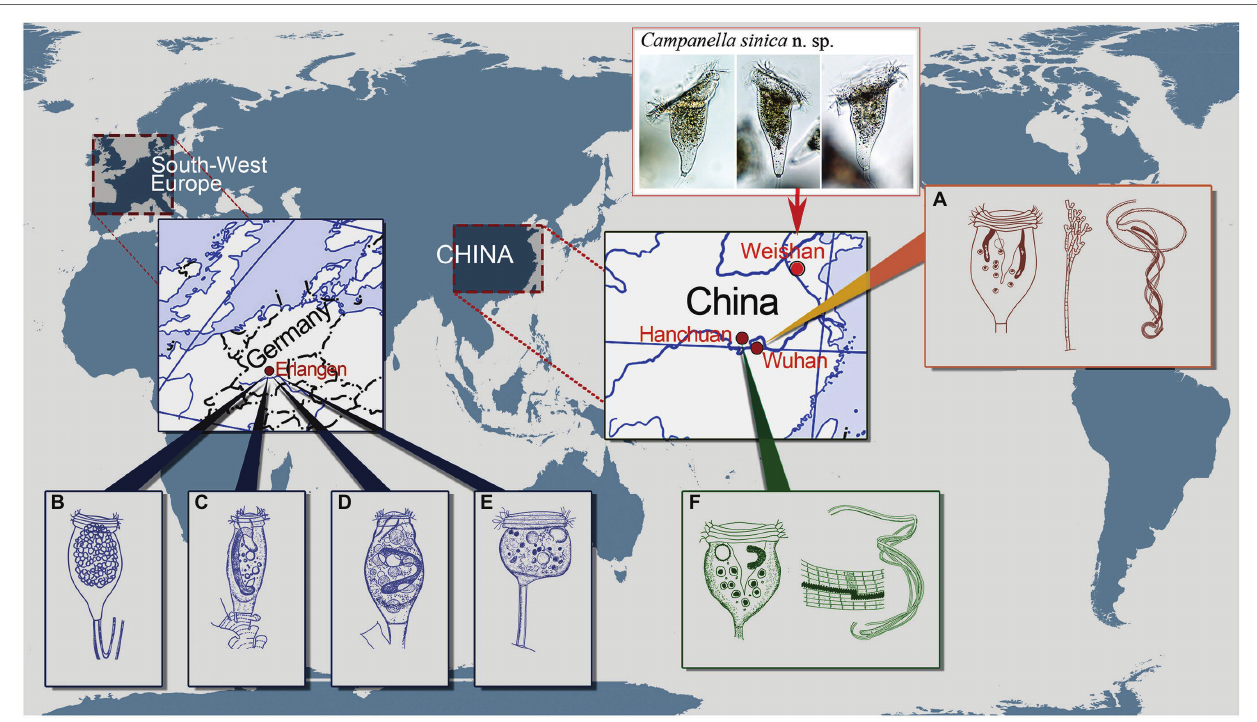
FIGURE 6 | Schematic drawings of Campanella species showing some localities of C. umbellaria (A,B,E) and type localities of C. purneri (C) , C. ovata n. grad. & n. comb. (D) , and C. hanchuanensis (F) . (A) After Shi et al. (2004) and Shen and Gu (2016). (B–E) After Nenninger (1948). (F) After Yu et al. (1995) and Shen and Gu